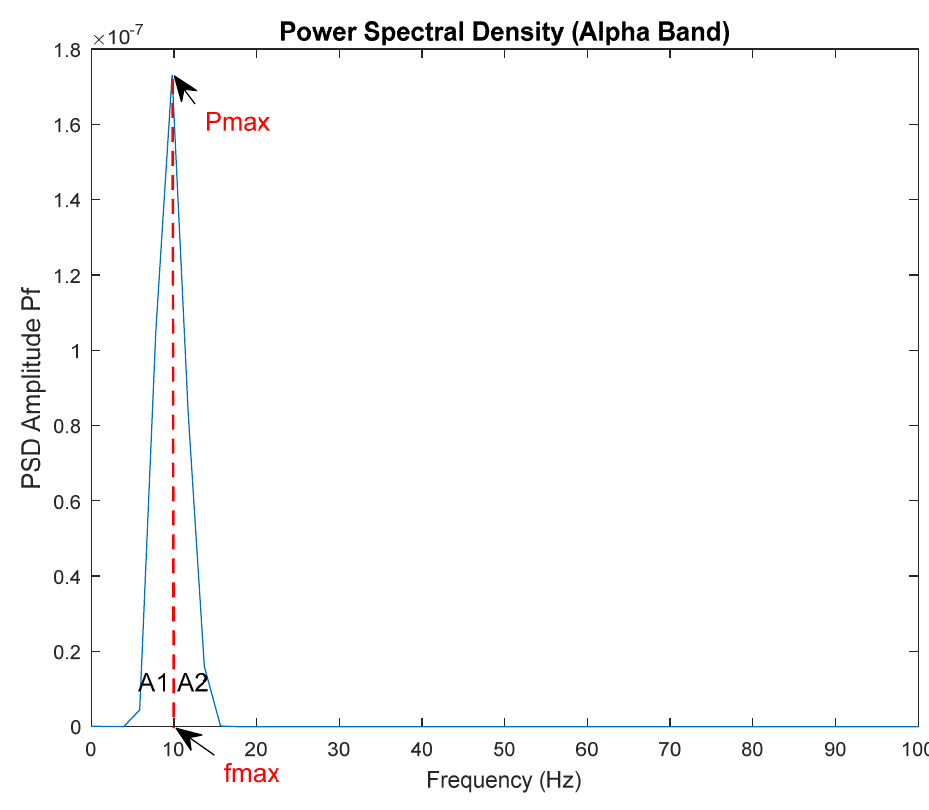
Figure 4. PSD graphic of F3-F4 channel EEG (a GCS 5 patient, first rest stage).